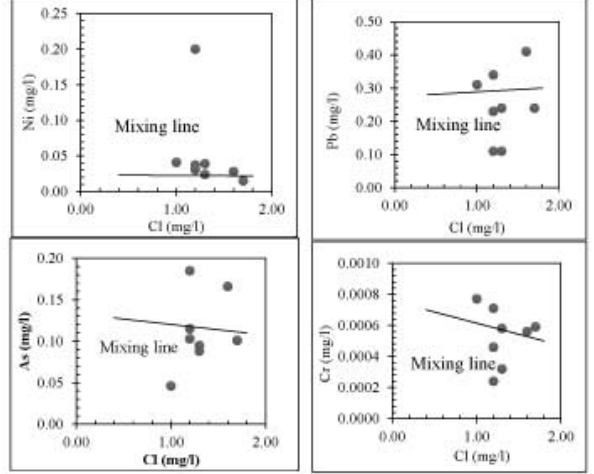
Figure 5: Process model plots for trace metals using Cl as the conservative tracer Conversely, data values that plots above the mixing line indicates that ions are being added to the stream. When the data points distribution is equal about the mixing line, it demonstrates equilibrium as presented in the two scenarios discussed above. From Fig. 5, point distribution of Mean concentration of trace metals obtained food crops